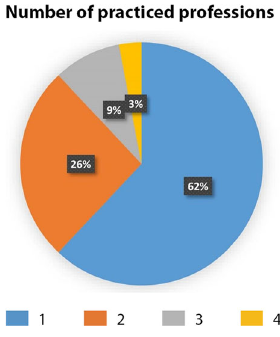
Fig. 9 Number of practiced professions (Source: the